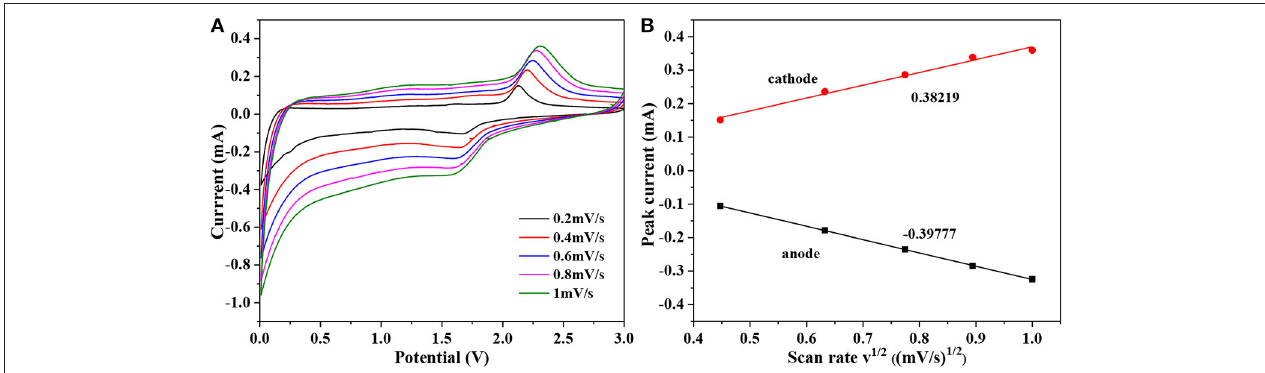
FIGURE 5 | (A) CV curves of Mo-TiO 2 @NC at different scan rates: 0.2, 0.4, 0.6, 0.8, and 1mV s − 1 . (B) The relationship between peak current ( i p ) and square root of the scan rate ( v 1 / 2 ).